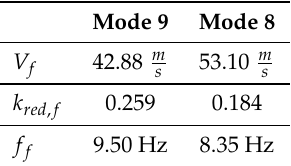
Table 2. Flutter boundaries of